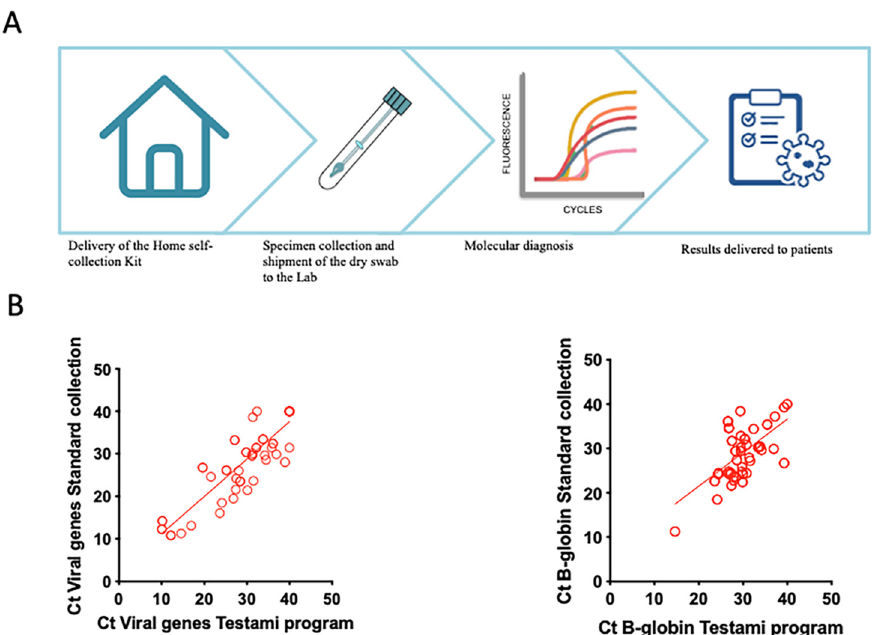
Figure 4. Representation and validation of Testami program. ( A ) Schematic representation of Testami program. ( B ) Correlation of Ct values of viral genes in sample collected using the Testami program and by standard procedures, Spearman’s test r = 0.8608 (CI95%: 0.7685 to 0.9180), p value < 0.0001 ( left panel); correlation of Ct values of B-globin gene in samples collected using the Testami program and by standard procedures (Spearman’s test r = 0.4318 (CI95%: 0.2889 to 0.5559), p value < 0.0001 ( right panel).